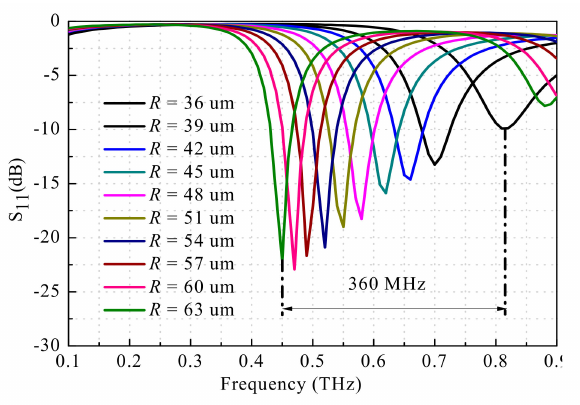
Figure 8. Simulated reflection coe ffi cients with di ff erent high impedance units.